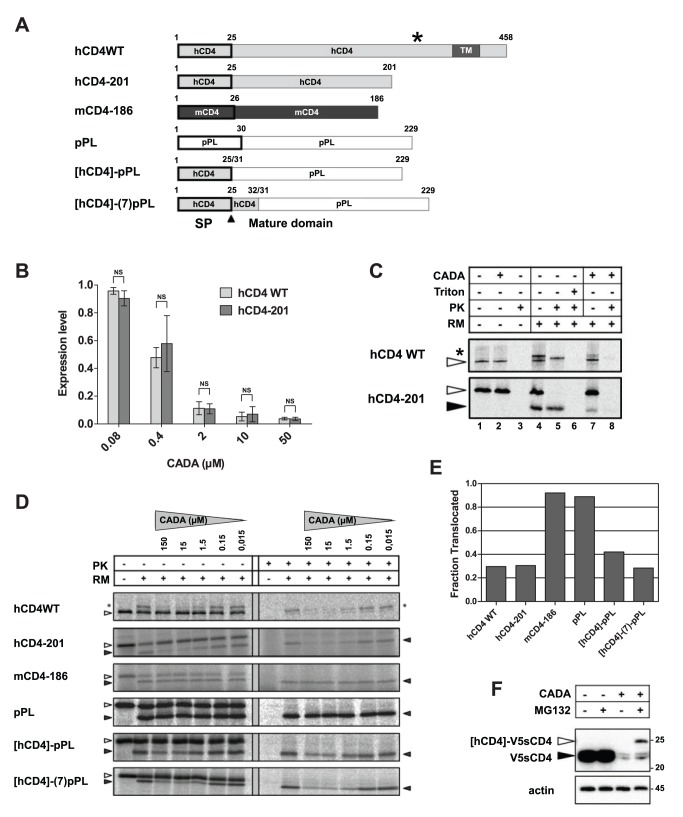
CADA dose-dependently inhibits co-translational translocation of human CD4.(A) Schematic representation of the constructs used. Numbers represent the corresponding amino acids of the pre-protein. The N-terminal SPs are indicated by a black rectangle. The star represents the N-glycosylation site in full length hCD4. (B) HEK293T cells were transiently transfected with the expression plasmids and left either untreated or treated with CADA for 48 h. Receptor expression levels were determined by flow cytometry and normalized to non-treated controls (n≥3). NS, not significant. (C) Transcripts encoding full length (hCD4 WT) and truncated (hCD4-201) hCD4 were translated in the presence of [35S]methionine and, where indicated, RMs and/or CADA (15 µM). Equal aliquots of the translated material were left untreated or treated with PK in the presence or absence of Triton X-100 (Triton). Samples were separated by SDS-PAGE and analyzed by autoradiography. The positions of precursor (open arrowhead), signal-cleaved (solid arrowhead), and glycosylated (asterisk) species are indicated. Of note is the lower appearance of the PK-protected glycosylated form of hCD4 WT (lane 5) compared to the non-PK form (lane 4), which is due to proteolytic cleavage of the 38 amino acid cytoplasmic domain, resulting in a smaller and faster migrating fragment. (D) As in (C), except that a 1∶10 serial dilution of CADA was used. (E) Translocation data of (D) quantified by phosphorimager analysis. The translocation efficiencies, at 15 µM CADA, normalized to control are indicated (mean values of at least three experiments). (F) Cytosolic degradation of precursor hCD4 in CADA-treated cells. HEK293T cells were transiently transfected with V5-tagged hCD4, treated with CADA (10 µM) and/or the proteasome inhibitor MG132 (200 nM). Cells were lysed in NP-40 buffer and analyzed by immunoblotting for CD4 with anti-V5 antibody. For the cell loading control, an anti-actin antibody was used. The predicted molecular mass for the SP-cleaved sCD4 (V5sCD4) was 22 kDa, whereas that of the precursor form ([hCD4]-V5sCD4) was 25 kDa. Molecular mass is in kDa. Similar data were obtained with 2 µM CADA. One representative experiment out of two is shown.